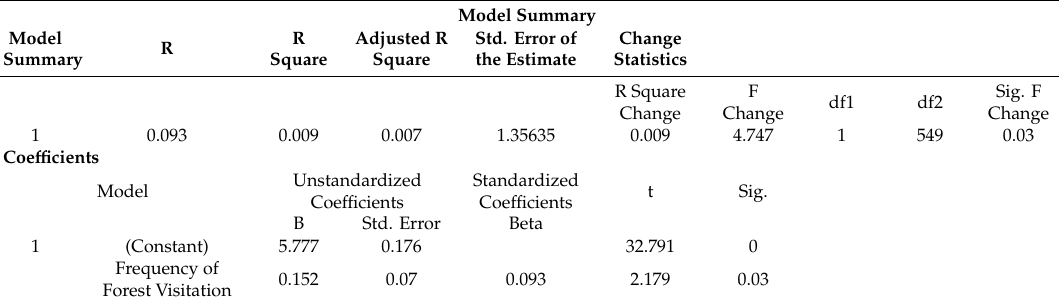
Table 2. Factors a ff ecting commitment to investment in forests outside urban